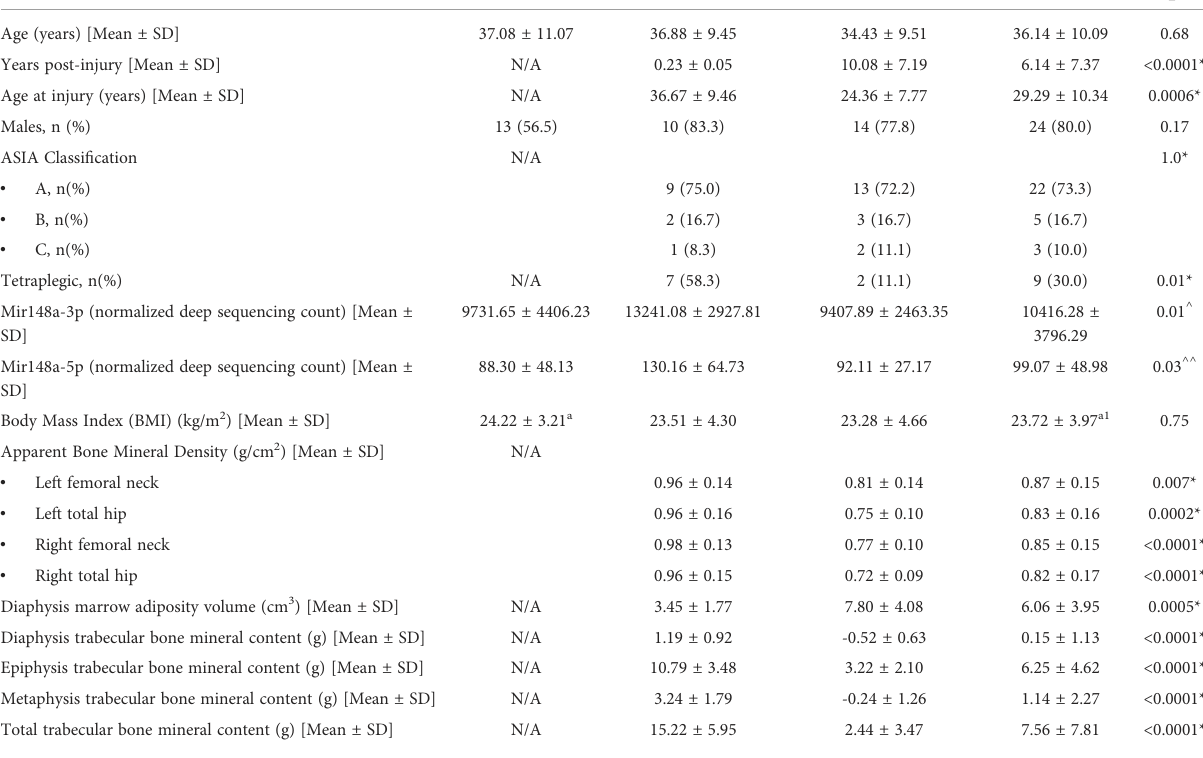
TABLE 1A Characteristics of